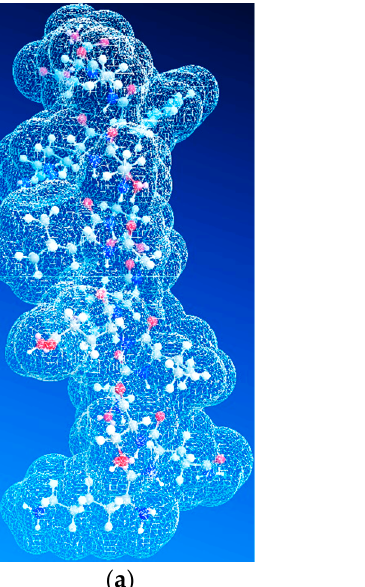
36,13,14 (24.30)94 + Al 3 + 36,13,14 ; ( b ) A β (1–16) S (1–16) S